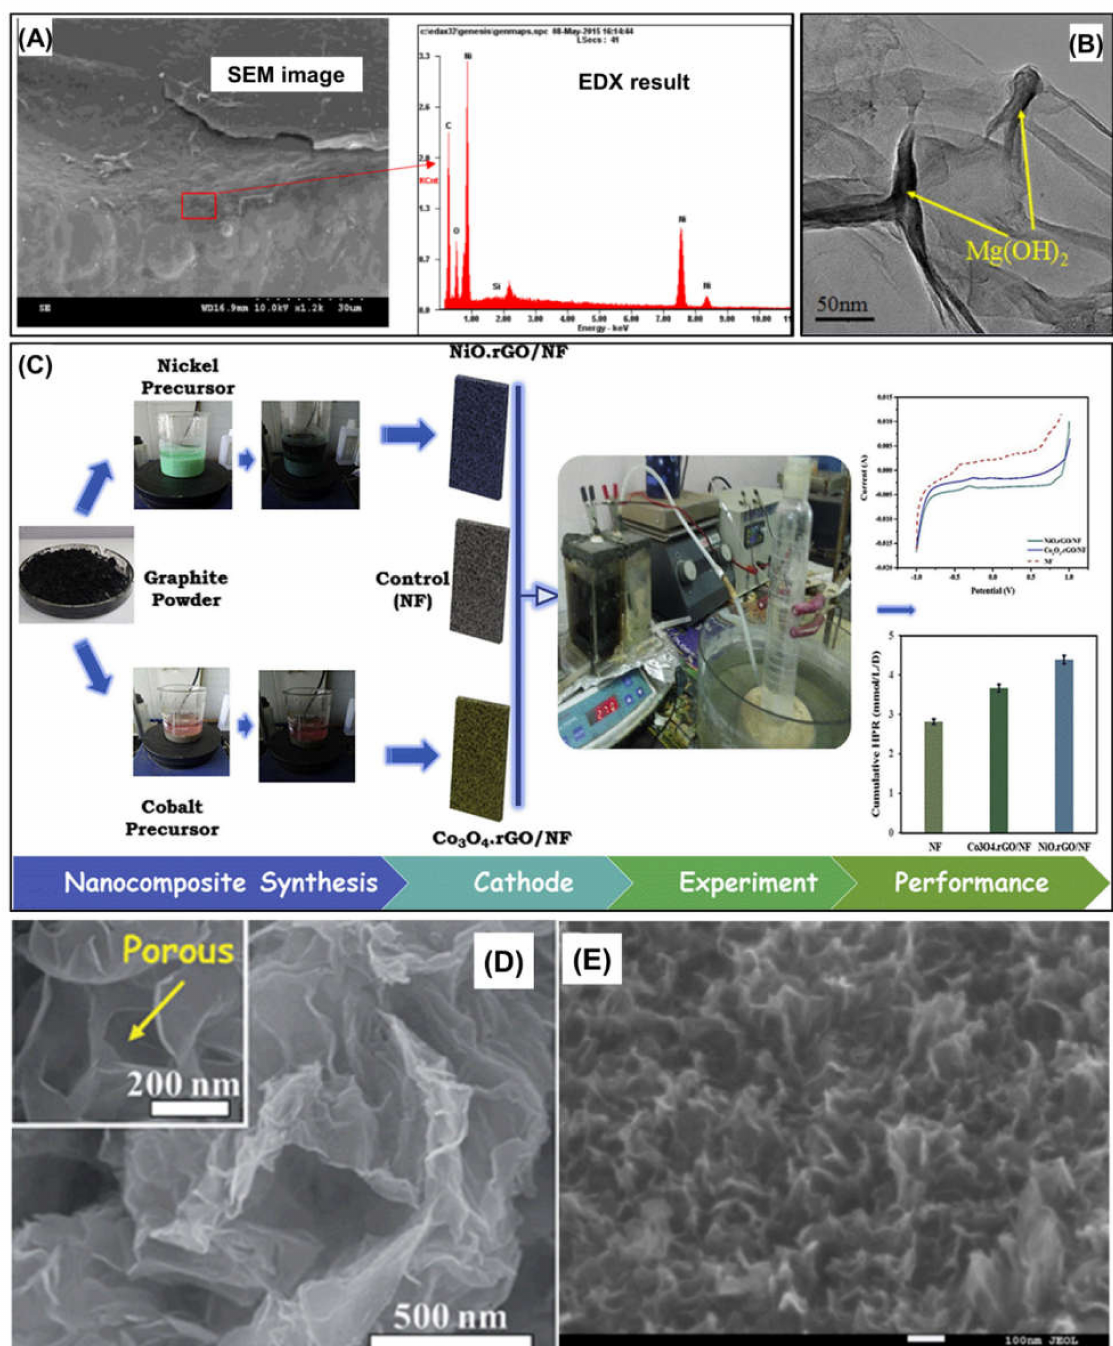
Figure 8. Two-dimensional nanomaterials used in MECs: ( A ) SEM image of graphene-coated Ni foam surface. Reprinted with permission from Ref. [50]. Copyright Elsevier 2016, ( B ) Mg(OH) 2 -decorated GO nanosheet. Reprinted with permission from Ref. [51]. Copyright Elsevier 2016, ( C ) schematic of NiO–rGO and Co 3 O 4 –rGO nanocomposites fabrication and their application in an MEC. Reprinted with permission from Ref. [52]. Copyright Elsevier 2020, ( D ) macroscopic and microscopic image of MoS 2 /N-doped GO composite electrode. Reprinted with permission from Ref. [55]. Copyright Royal Society of Chemistry 2014, and ( E ) vertically-created MoS 2 on rGO. Reprinted with permission from Ref. [57]. Copyright ESG